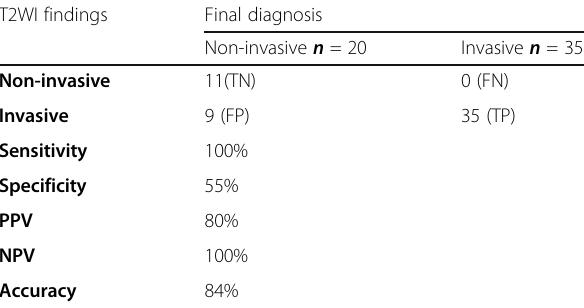
Table 4 Diagnostic performance of T2WI in assessment